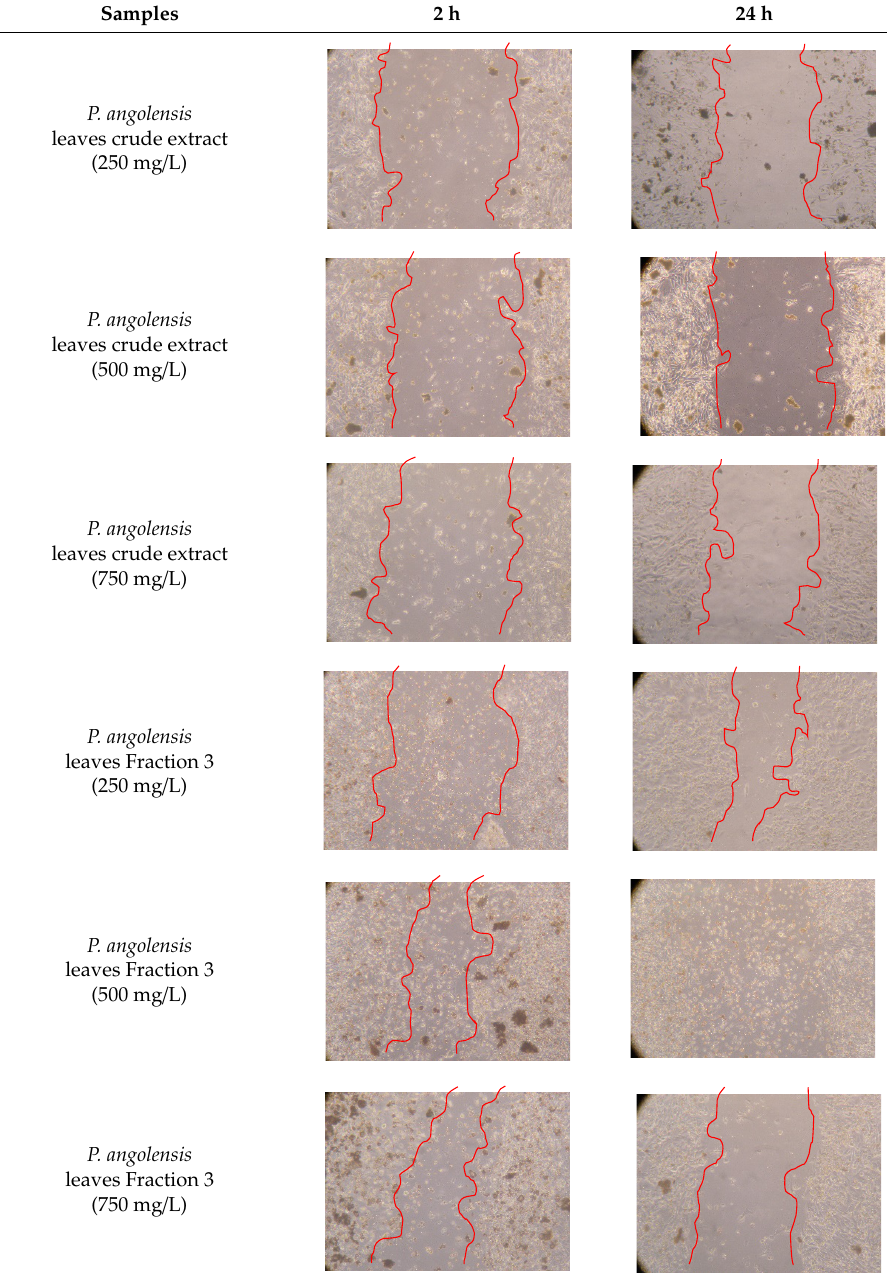
Table 10. Microscopic images obtained from the scratch wound-healing assay with the selected samples of P. angolensis (Magnification: 100×).